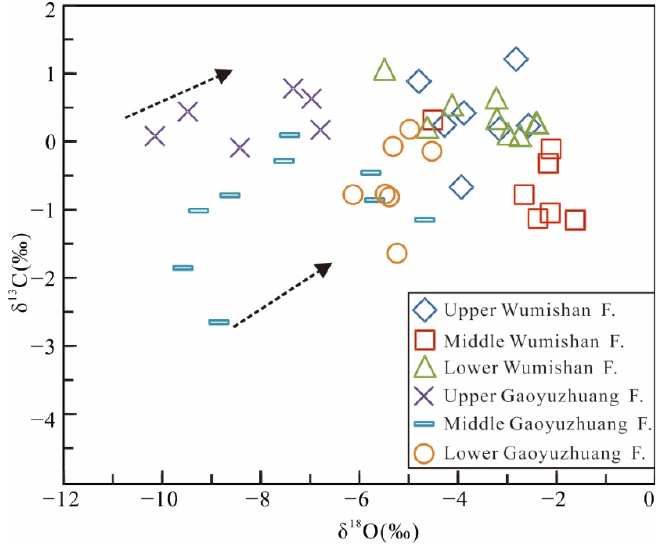
Figure 8. Plot of δ 13 C versus δ 18 O values for the carbonate rocks from the Gaoyuzhuang and Wumishan Formations.